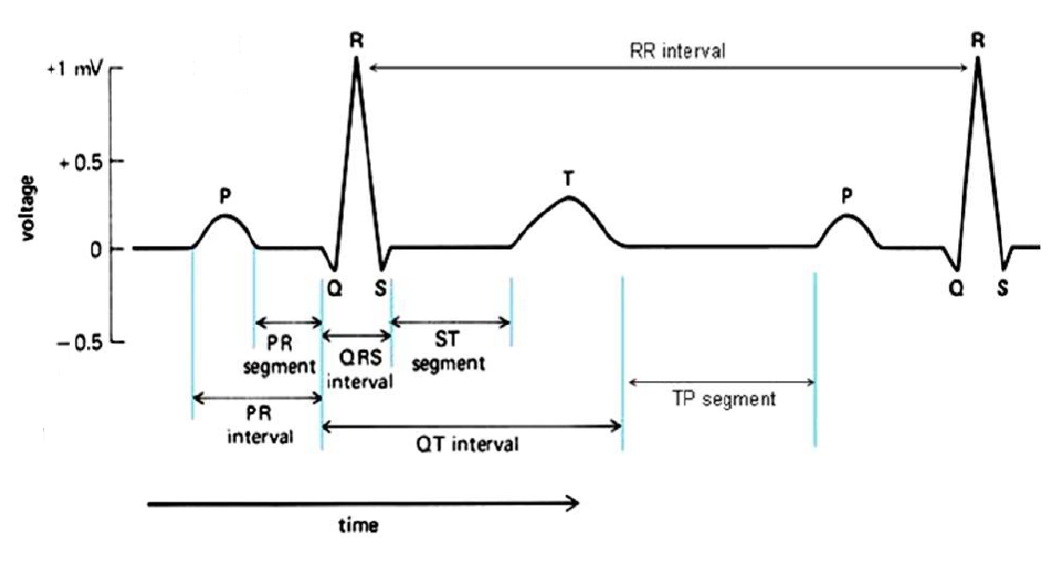
Figure 2. ECG R-R interval and fiducial